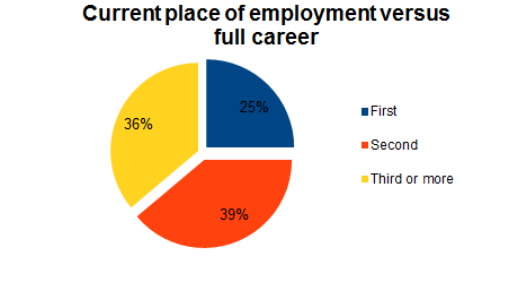
Figure 26 - The current place of